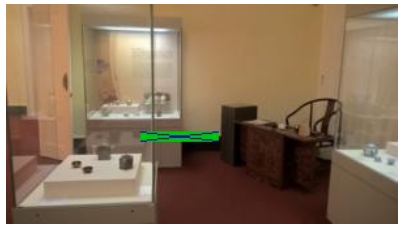
Figure 15. “Cross of thickness 1 in a filled rectangle”.